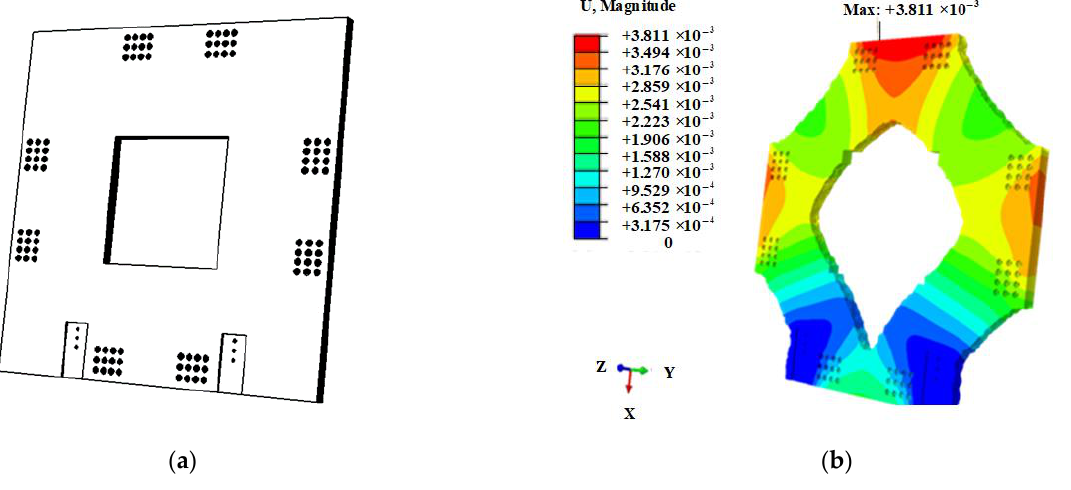
Figure 5. Topological optimization of the support plate of high-temperature/biaxial tensile test de- vice. ( a ) Geometric model before optimization; ( b ) optimized geometric model. device. ( a ) Geometric model before optimization; ( b ) optimized geometric